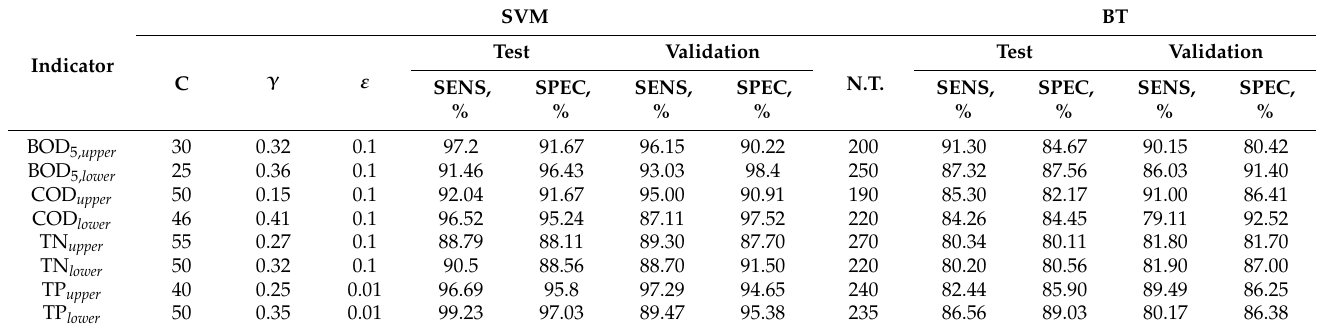
Table 4. List of determined parameters (C, ε , γ ) describing the structure of SVM models for the classification of wastewater quality at the inflow to the treatment plant and measures of matching the calculation results to the measurement (SPEC, SENS ) for the training set and test set for the Sitk ó wka—Nowiny